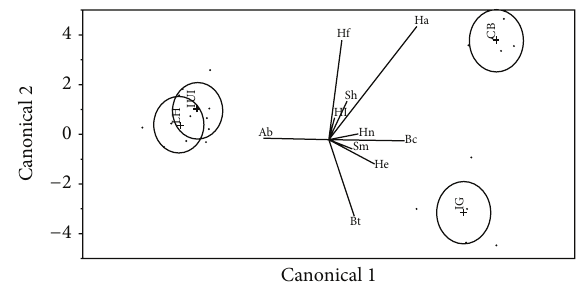
Figure 4: Discriminant analysis of holothuroid abundance by sampling site. This canonical plot shows the points and mul- tivariate means in the two dimensions that best separate the groups. Labeled circles represent multivariate means for each site sampled. The size of the circles corresponds to a 95% confi- dence limit for the mean. Groups that are significantly different have nonintersecting circles. Labeled rays emanating from the grand mean show the directions of the variables (species) in the canonical space. CB—Coral Beach; JG—Japanese Gardens; IUI—Interuniversity Institute; LH—Lighthouse. Ab— Actinopyga bannwarthi ; Bc— Bohadschia cousteaui ; Bt— B . tenuissima ; Ha— Holothuria atra ; He— H. edulis ; Hf— H. fuscogilva ; Hl— H. leucospi- lota ;Hn— H.nobilis ;Sm— Synaptamaculata ;Sh— Stichopushorrens